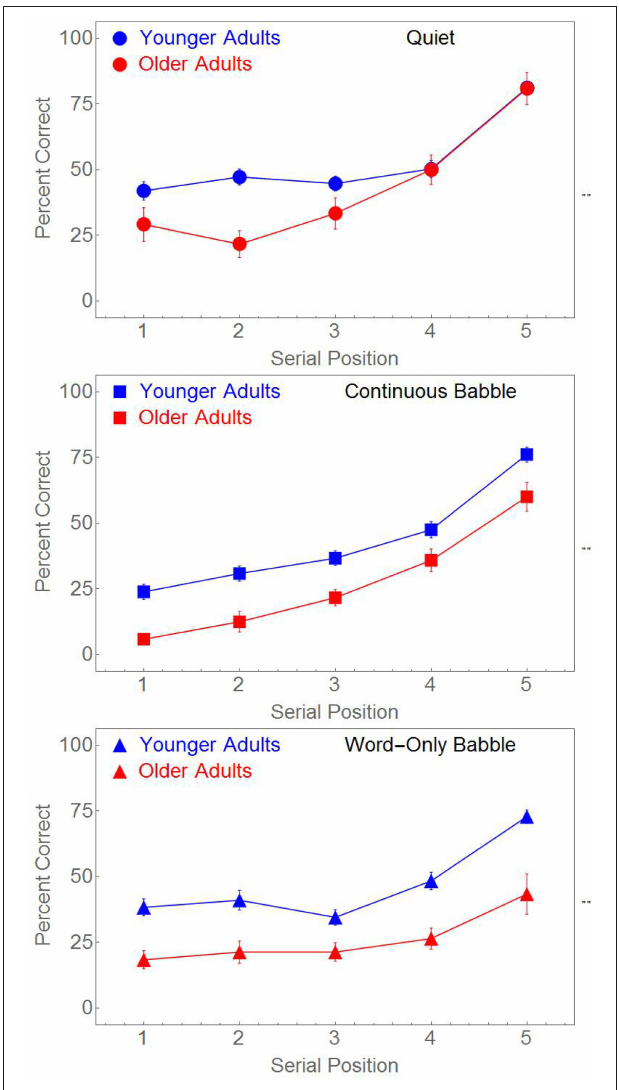
FIGURE 4 | Percent Correct word identification as a function of the serial position of the word pairs for younger and older adults. Different masking conditions are shown in panel (as labeled). Standard error bars are